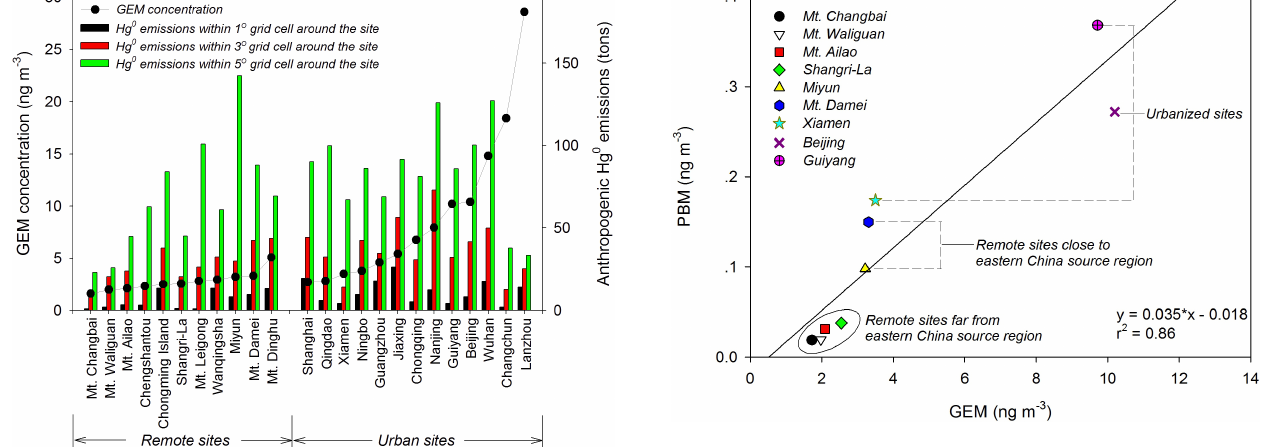
Figure 3. Correlation between GEM and PBM (Hg–P 2 . 5 ) concen- trations in remote and urban areas of